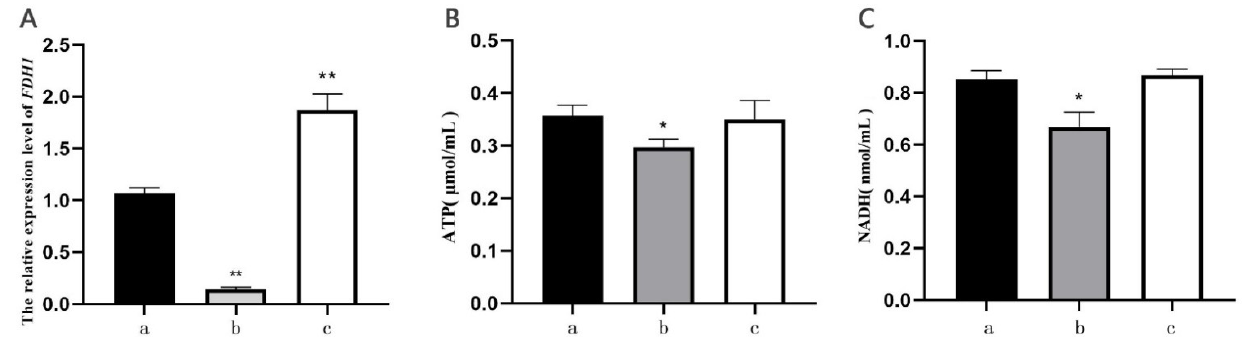
Figure 3. The influence of sugar stress on the relative expression of FDH1gene ( A ), ATP con- tent ( B ) and NADH content ( C ) of BY4741, BY4741 (cid:52) scFDH1 and BY4717zmFDH1. a: BY4741, b: BY4741 (cid:52) scFDH1, c: BY4717zmFDH1 (one-way analysis of variance (ANOVA) followed by Tukey test). * represents significant difference, p value < 0.05, and ** represents extremely significant difference between treatment and control, p value <